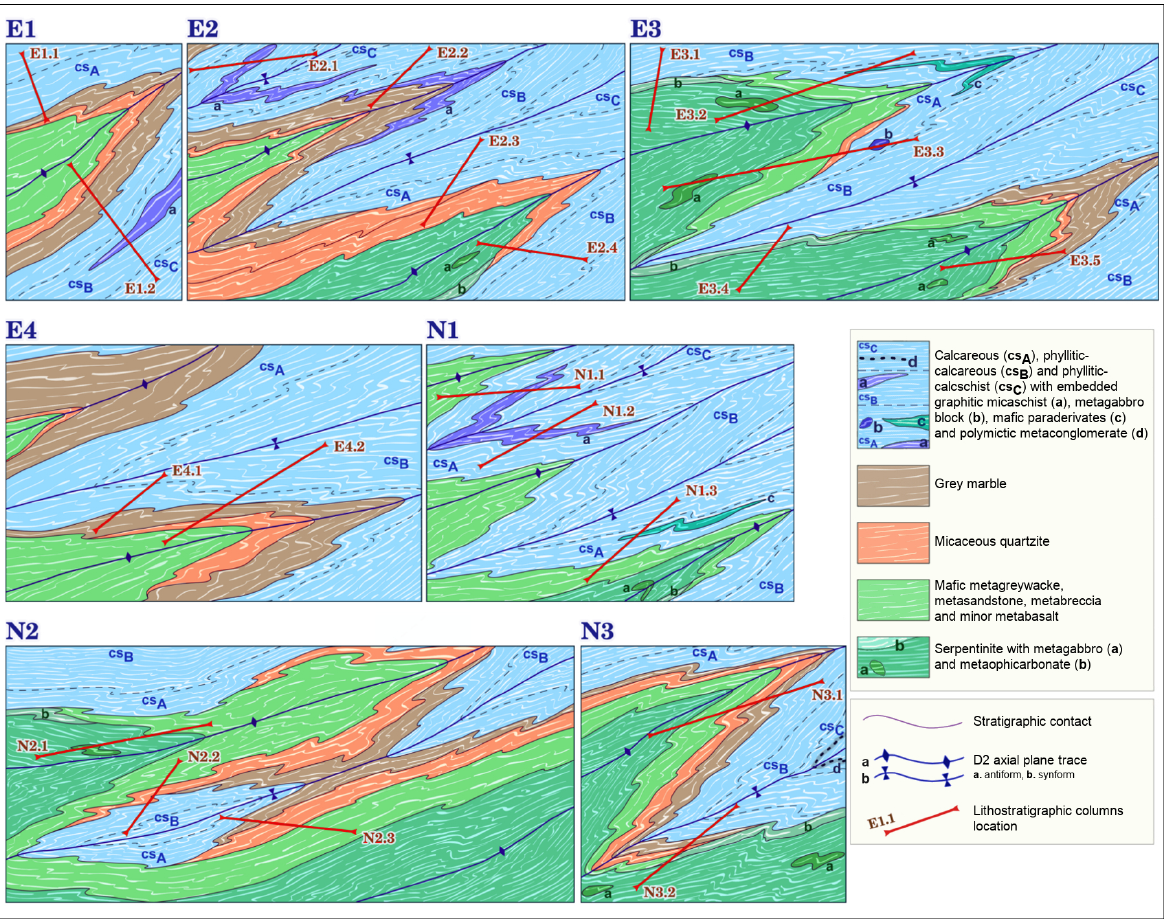
Figure 3. Schematic cross sections (not to scale) traced in Figure 2b, showing the geological-structural setting and related main deformational structures (i.e., D2 large-scale isoclinal sheath folds in N2 ). Red lines indicate the location of well- preserved stratigraphic sequences used for the reconstruction of lithostratigraphic columns shown in Figure